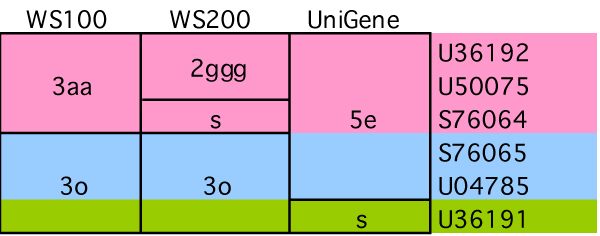
Cluster 5e. Distribution of the six mRNA sequences of which five are UniGene Cluster 5e. Shaded colors represent mRNA sequences from the same gene as determined by alignment analysis and literature review.